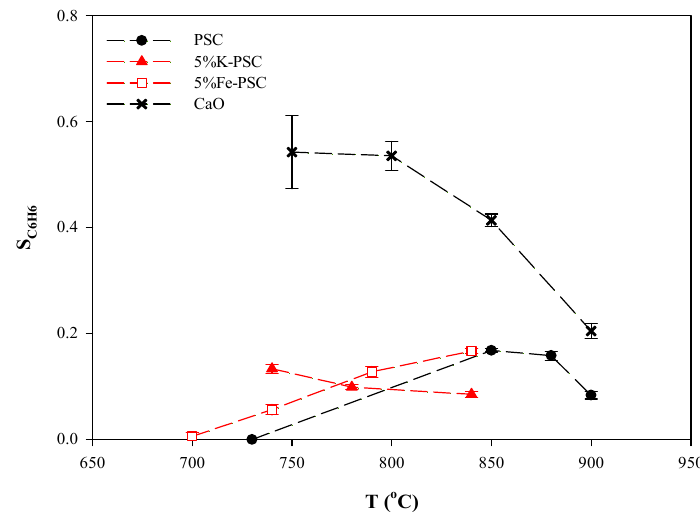
Figure 9. S C6H6 of PSC, 5%K-PSC, 5%Fe-PSC, and CaO at different temperatures.